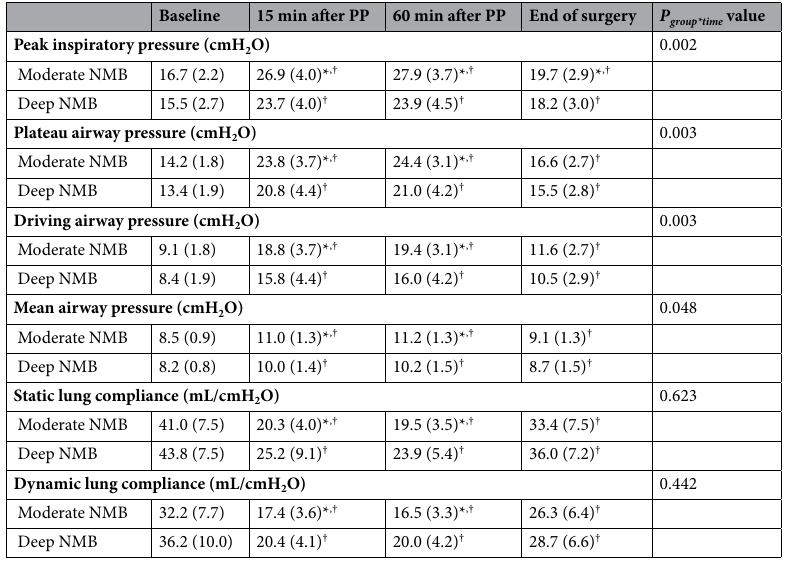
Table 2. Intraoperative respiratory mechanics. Values are presented as mean (standard deviation). Baseline means after anesthetic induction. Driving airway pressure means the pressure gradient from plateau pressure to positive end-expiratory pressure. Abbreviations: NMB neuromuscular block. * P < 0.05 between-group comparison. † P < 0.01 versus ‘baseline’ in each group.